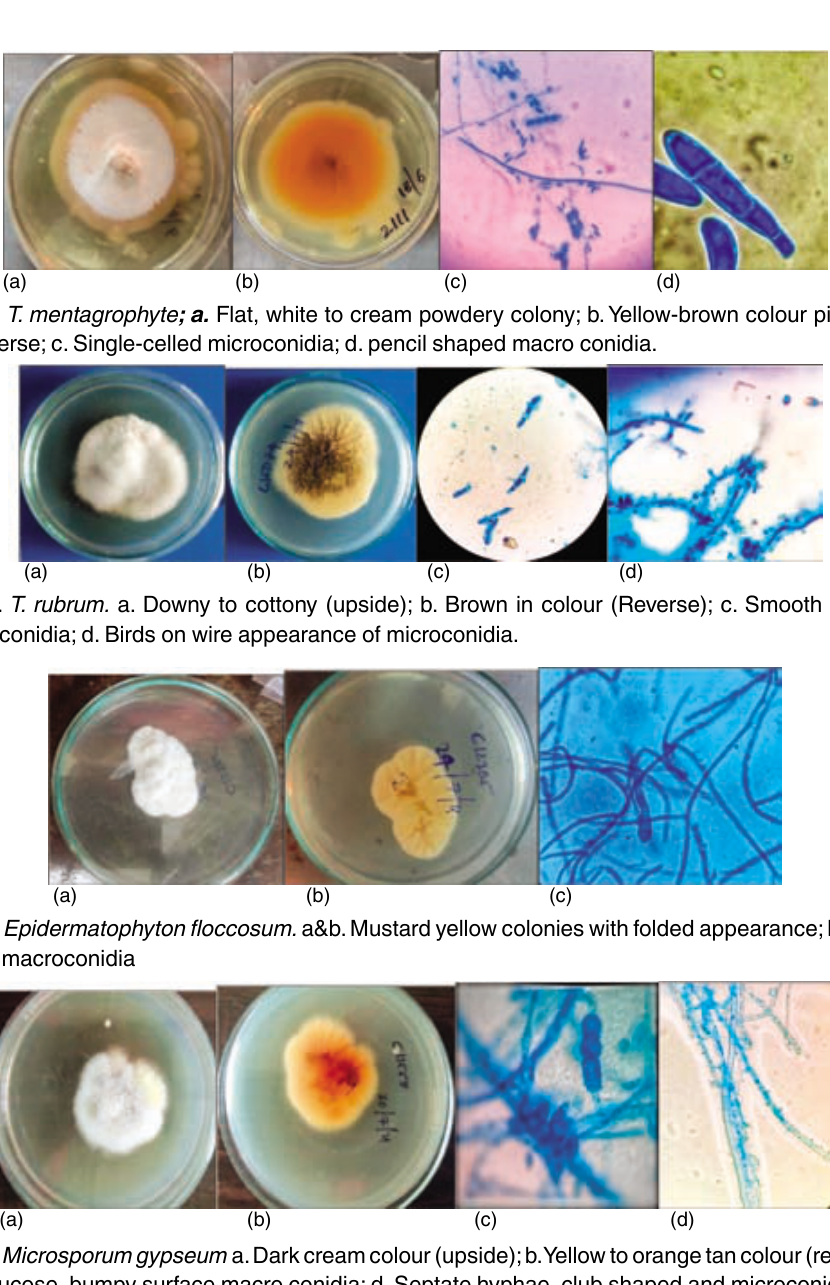
Fig. 4. Microsporum gypseum a. Dark cream colour (upside); b. Yellow to orange tan colour (reverse) c. Verrucose, bumpy surface macro conidia; d. Septate hyphae, club shaped and